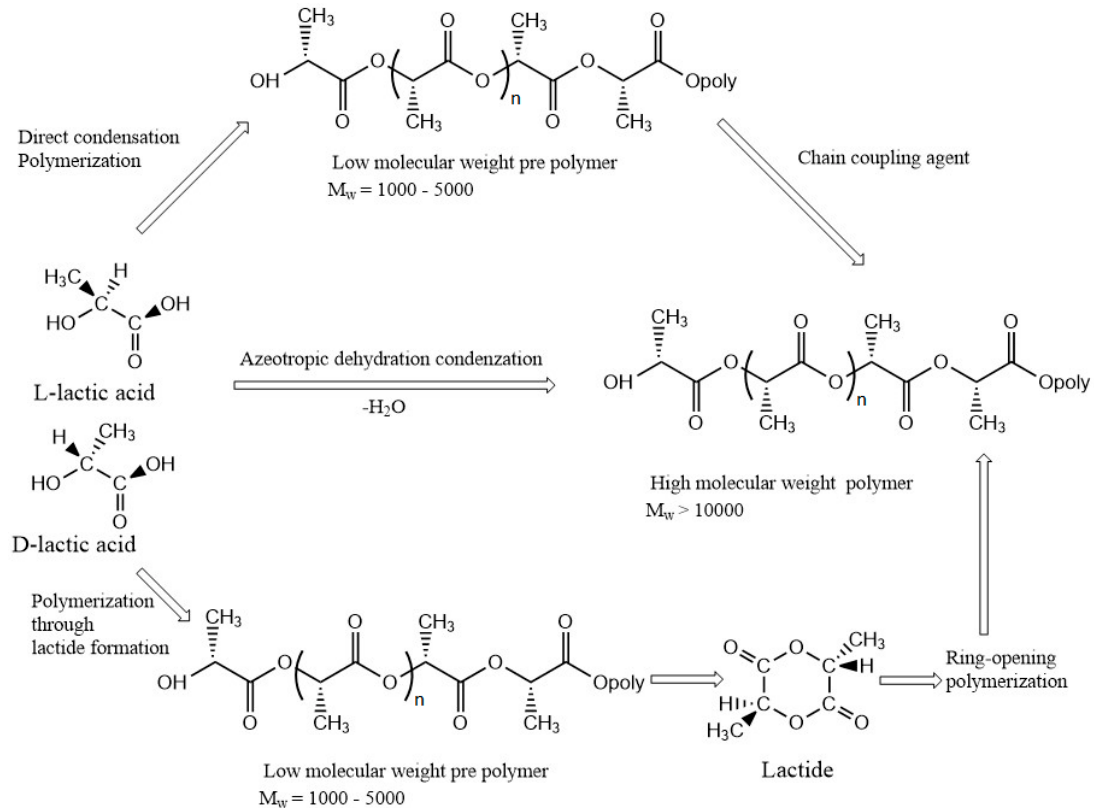
Figure 5. Three main routes for obtaining high molecular weight poly(lactic acid) (PLA).